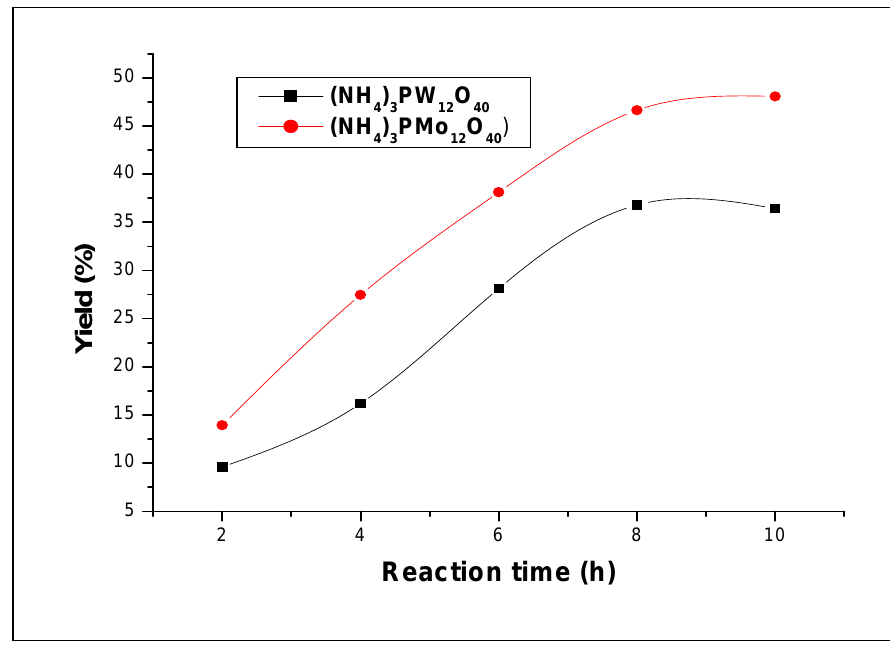
Figure 7. Effect of the reaction time on the styrene polymerization (in dichloromethane) using (NH ) PW O and (NH ) PMo O catalysts. Polymerization was carried out at 4 3 12 40 4 3 12 40 25 ºC using 10 mg of